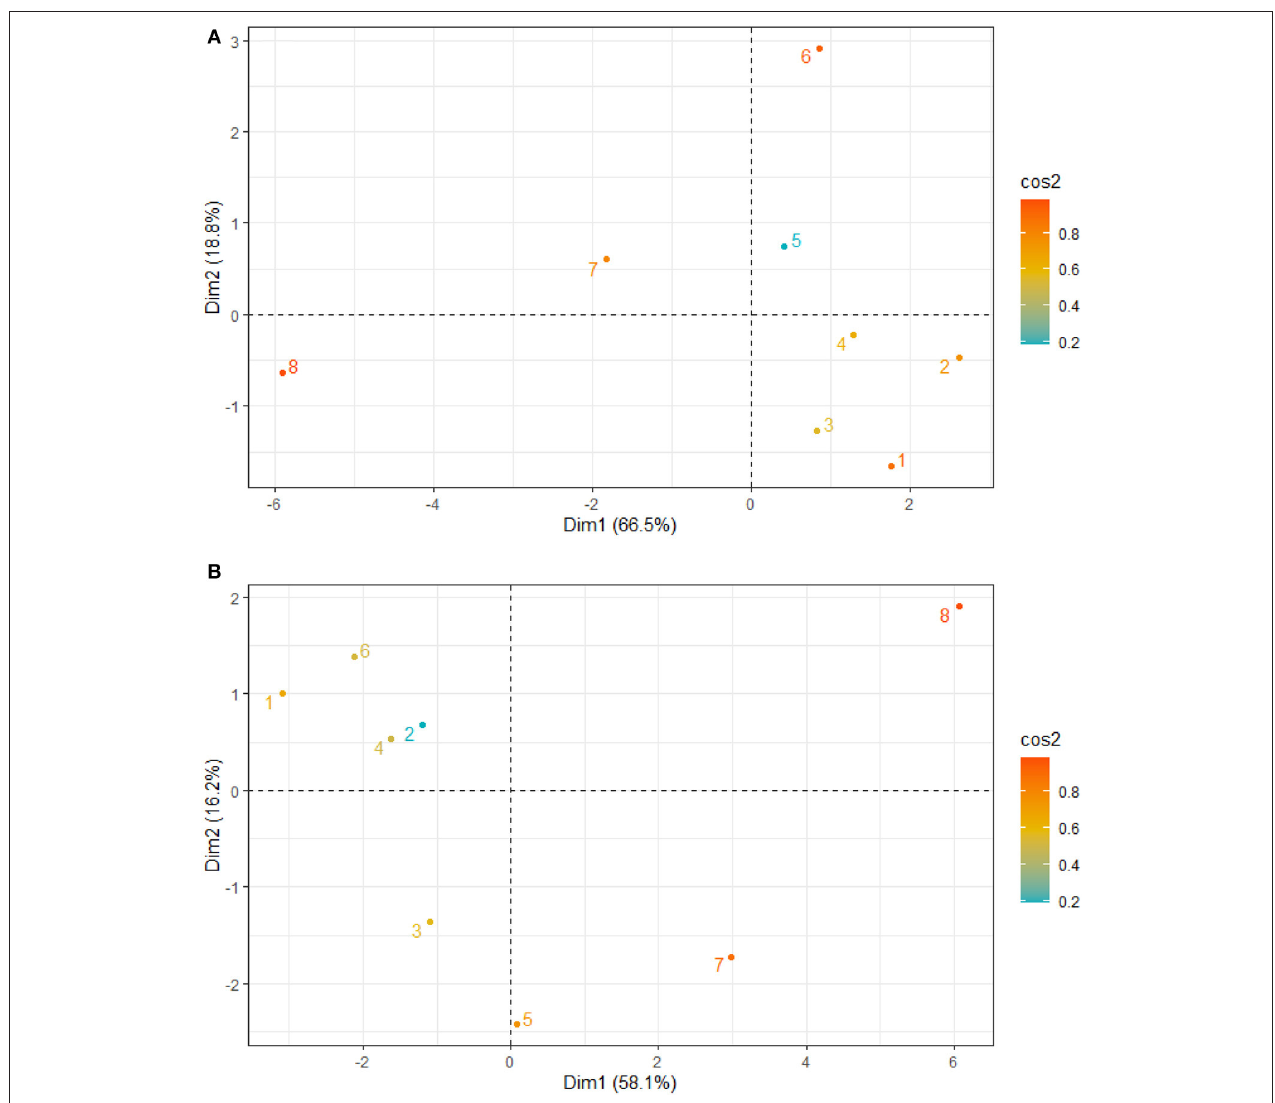
FIGURE 4 | Principal component analysis site contribution to total variation and grouping of Sites 1–8 for the relationship between (A) sediment grain size and nutrients (B) nutrients, physicochemical parameters, antioxidants, and mangrove height.